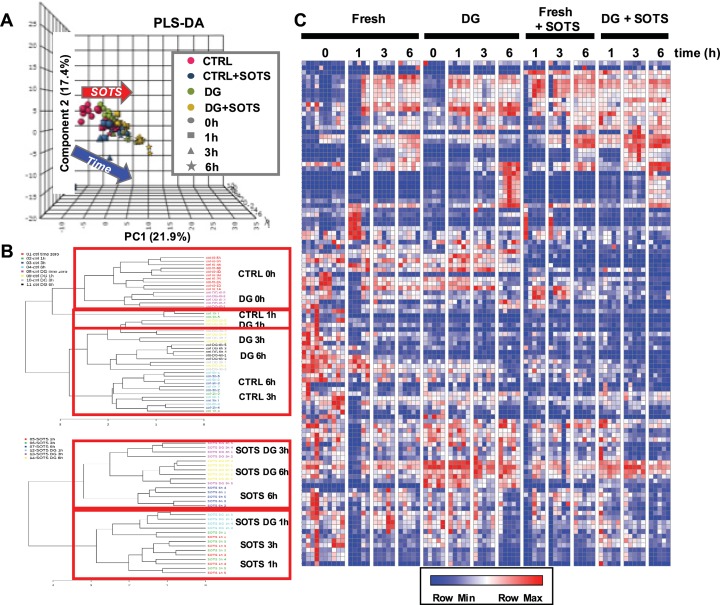
Unsupervised analysis of metabolomics data via PLS-DA, with dendrograms for time course hierarchical clustering and heat maps, visually indicating a time course and SOTS dependency of the metabolic phenotypes observed in fresh RBC and matched DG RBCs.(A) The impact of time and SOTS treatment informed sample clustering along principal components 1 and 2 (explaining 21.9 and 17.4% of the total variance, respectively). Both (A) PLS-DA and (B) hierarchical clustering analyses confirmed that control and DG groups fell into the same clusters at the tested time points, both in the absence and presence of SOTS. (C) Heat maps visually indicate the time course and SOTS dependency of the metabolic phenotypes observed both in fresh RBC and DG groups.